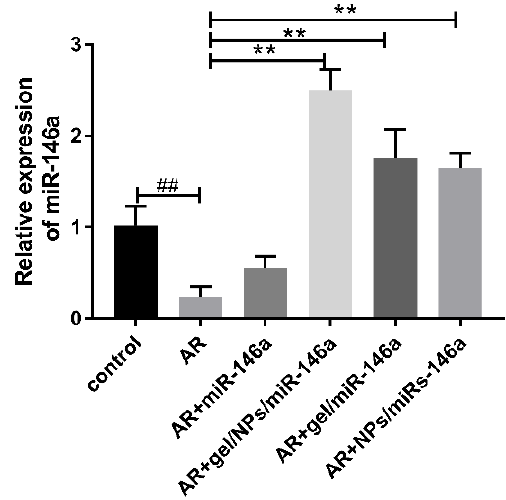
Figure 6. ( A ) Apoptosis of nasal epithelial cells determined by TUNEL staining (400×). ( B ) Quantitative analysis of the apoptosis rate of nasal epithelial cells. Data represent the mean ± SD of three independent experiments. ## p < 0.01 compared with the control group; ** p < 0.01 compared with the AR group.